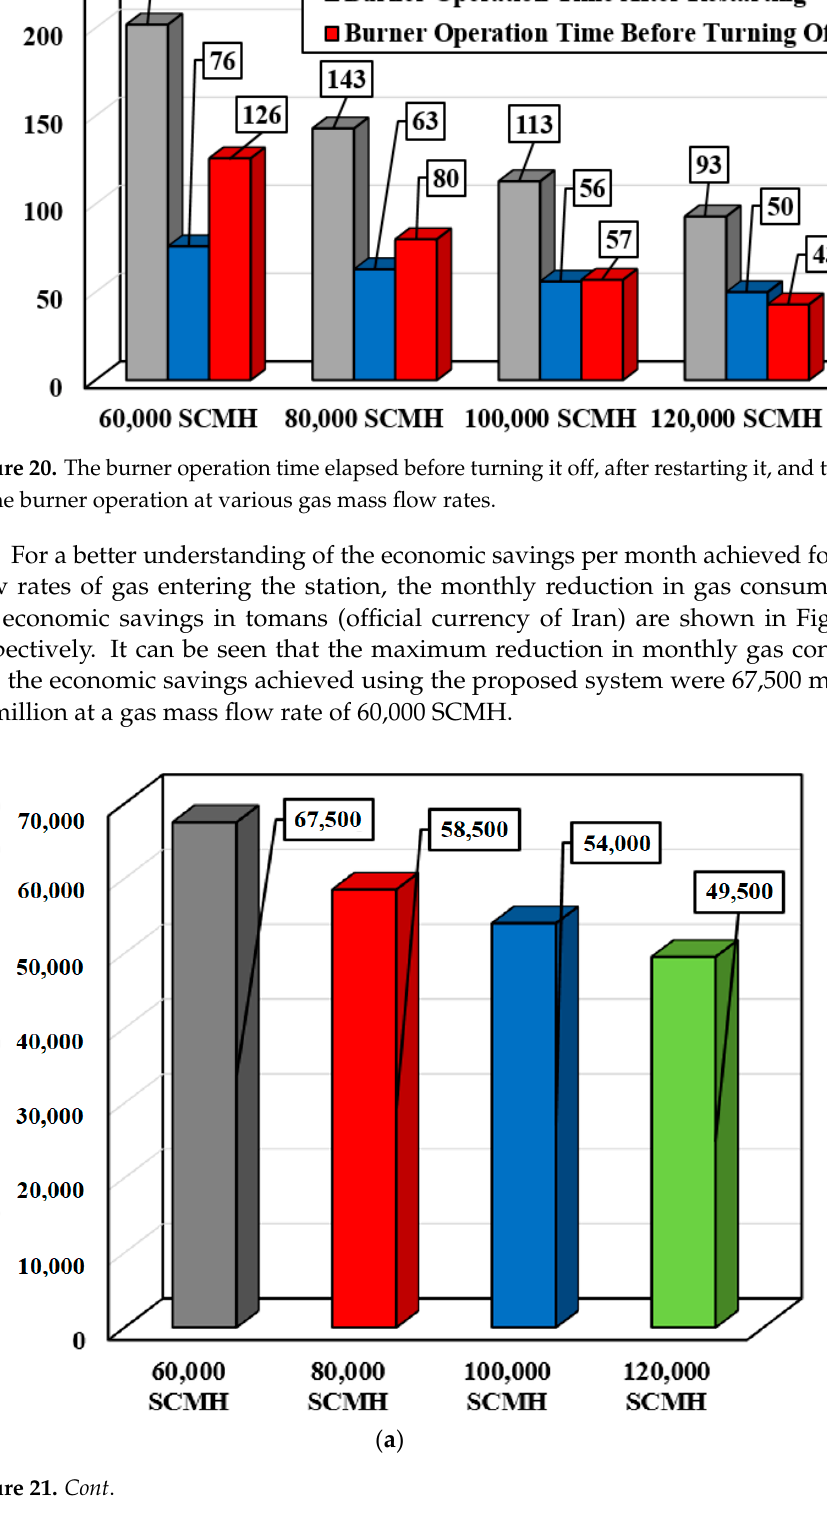
( b ) Figure 21. ( a ) The monthly reduction in gas consumption, and ( b ) the economic savings at different gas mass flow rates in one month. 4. Conclusions In this paper, the thermal performance of a gas heater of a pressure ‐ reducing station at a pressure of 700 psi (4826.33 kPa) was numerically investigated. According to the nu ‐ merical results, the thermal efficiency of the considered heater was about 70%, and at 100% full load and 50% full load, the gas temperature increased to 16.5 and 31 degrees, respec ‐ tively. According to the studies performed, at a pressure of 700 psi (4826.33 kPa), the reg ‐ ulator causes a temperature drop of about 5 degrees. To prevent the gas from freezing in the regulator, according to the current standard and the station’s instructions, the gas should leave the heater at a temperature of about 20 °C at different operating pressures and enter the regulator, before finally entering the trunk line at 15 °C. According to the modeling results, the outlet temperature at a pressure of 700 psi (4826.33 kPa) is higher